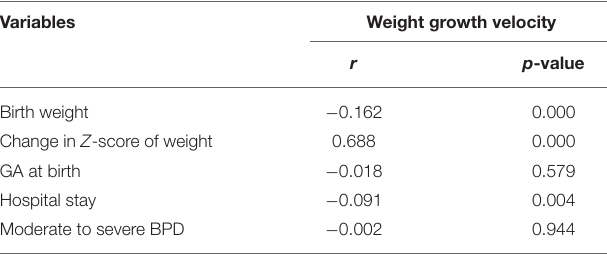
TABLE 4 | Correlation of influencing factors with weight growth